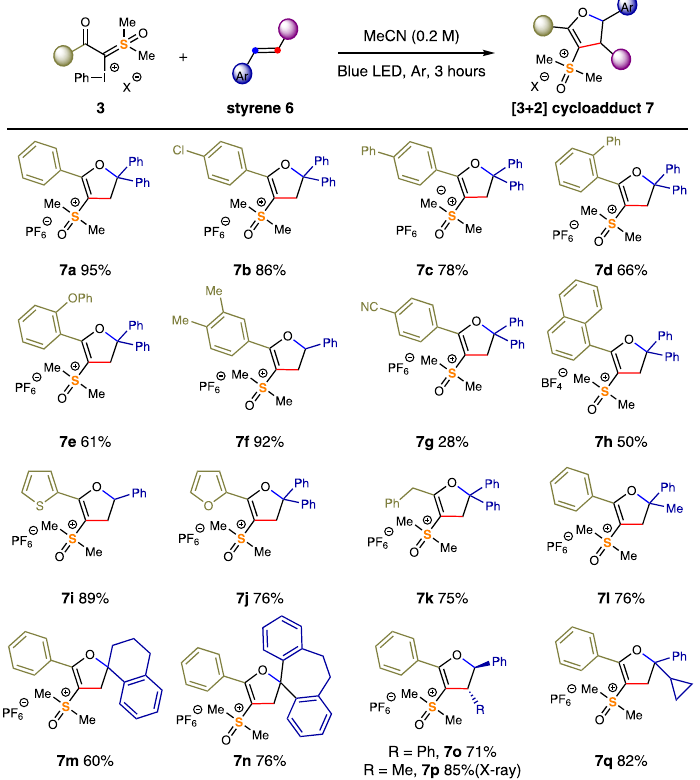
Fig.4|Thescopeofvisible-light-mediated[3+2]cycloadditionofstyrenes. Reactionswereperformedbymixingstyrene(0.4mmol,2equiv.)andreagent 3 (0.2mmol,1 equiv.) in 1.0mL of MeCN at room temperature, under irradiation of blue LED for 3h, isolated yields. See Supplementary Methods for experimental